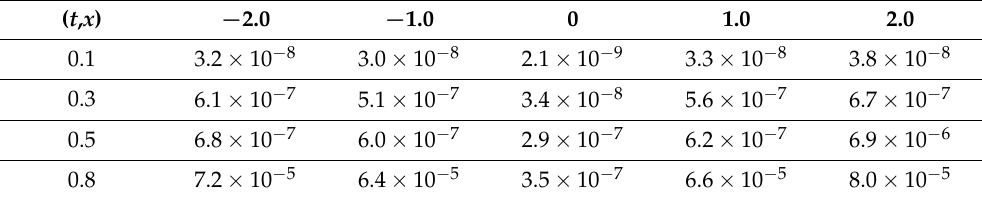
Figure 2. ( Above ) Three-dimensional illustrations of the numerical simulation and exact solution, and two-dimensional illustration of the approximation of | u | 2 ; ( Below ) three-dimensional illustrations of the numerical simulation and exact solution, and two-dimensional illustration of the approximation of | v | 2 for Case B. Table 2. Case B: Absolute error for different values of ( x , t ) considering N = 15